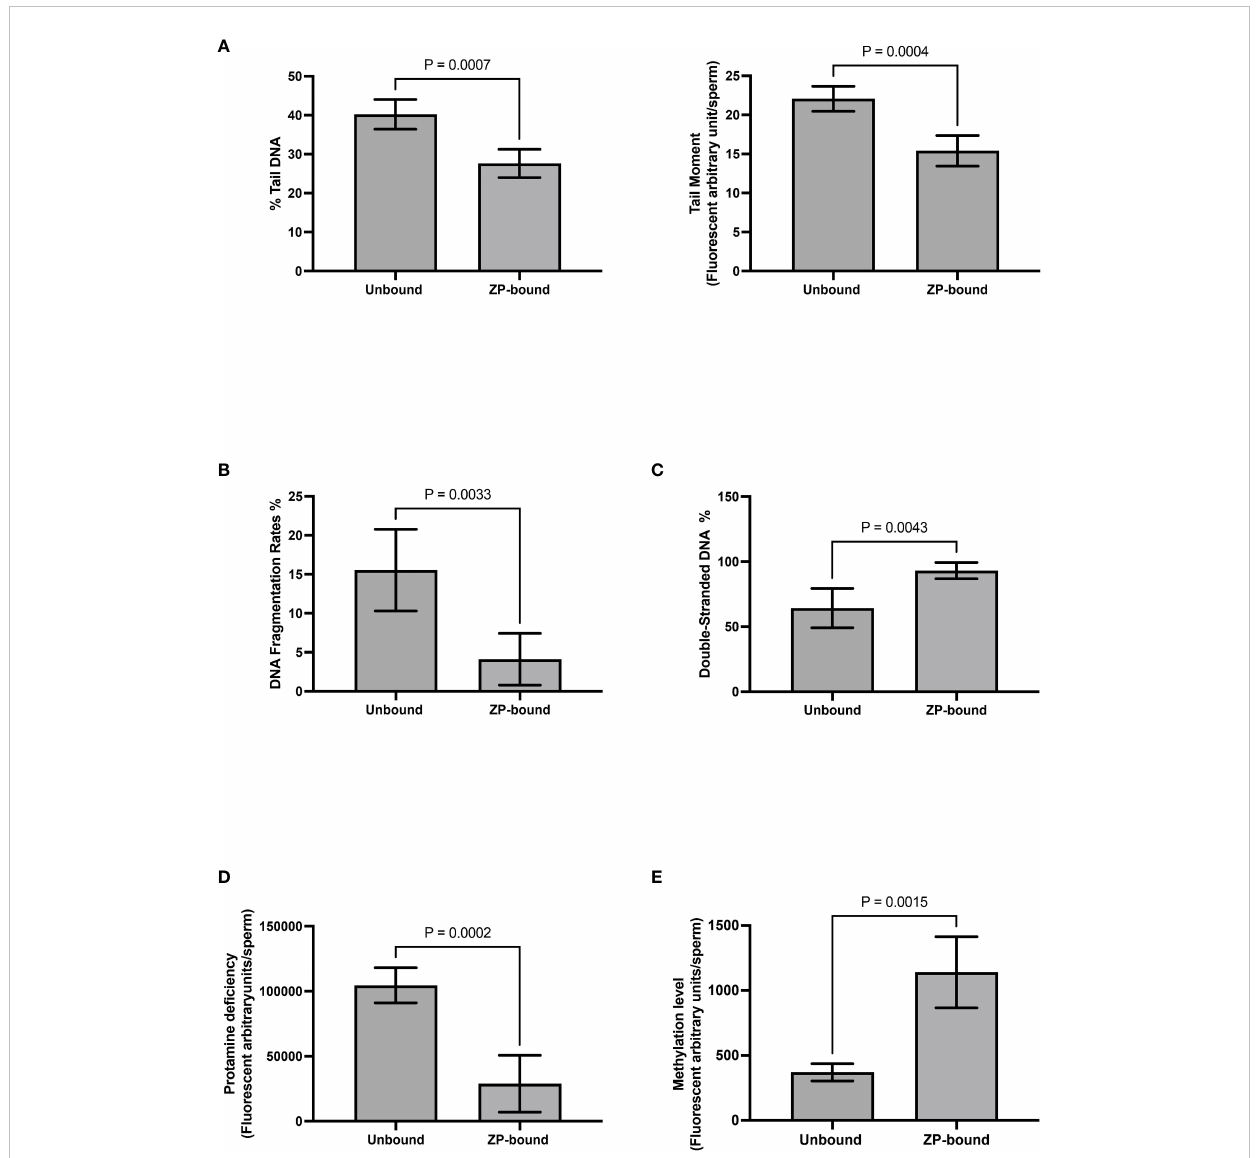
FIGURE 5 Evaluation of genetic qualities and epigenetic pro fi le of ZP-bound and unbound spermatozoa. Quanti fi cation of (A) Comet-positive spermatozoa with different levels of DNA damages as re fl ected by the (Left) %tail DNA and (Right) tail moment (B) TUNEL-positive spermatozoa (C) AO-stained spermatozoa with double-stranded DNA in green fl uorescence D) CMA3-positive spermatozoa with different levels of protamine de fi ciency as re fl ected by the yellow fl uorescence intensity. (E) 5-Mc-positive spermatozoa with different levels of methylation as re fl ected by the green fl uorescence intensity. All data are represented as mean ± SD (n=5 for (A – E) ,